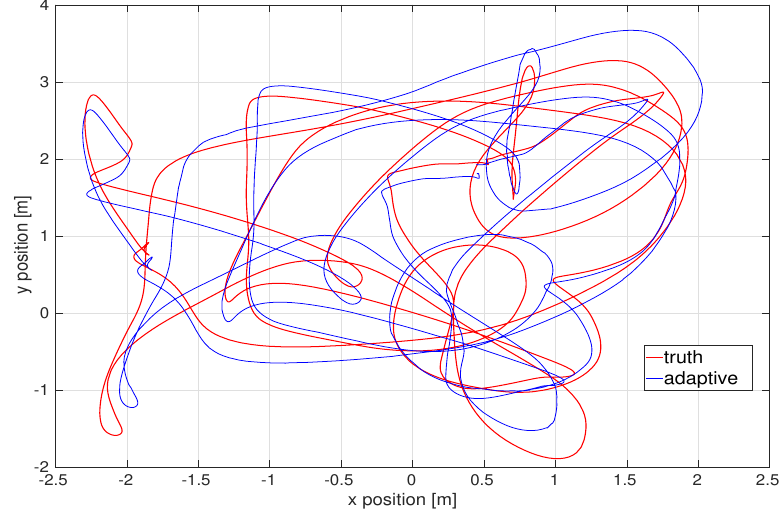
Figure 9. Top-down view of flight trajectory of the EuRoC V1 medium dataset by the latency compensated